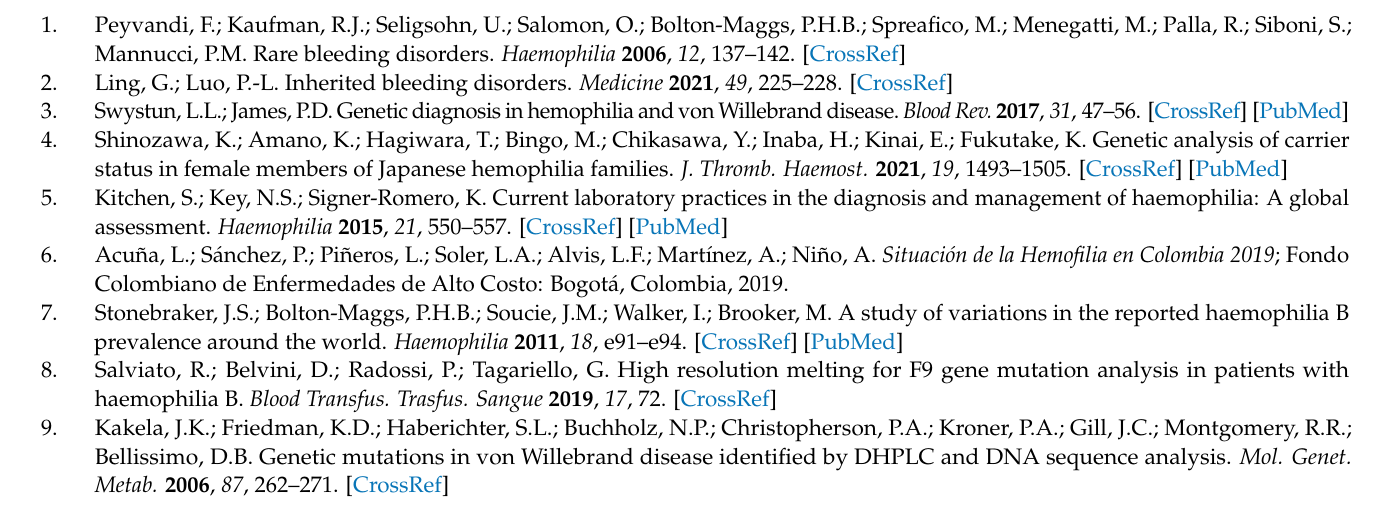
Table S1: Phenotype characteristics of hemophilia A patients; Table S2: Phenotype characteristics of hemophilia A patients; Table S3: Phenotype characteristics of hemophilia B patients; Table S4: Phenotype characteristics of von Willebrand Disease patients; Table S5: Phenotype characteristics of von Willebrand Disease